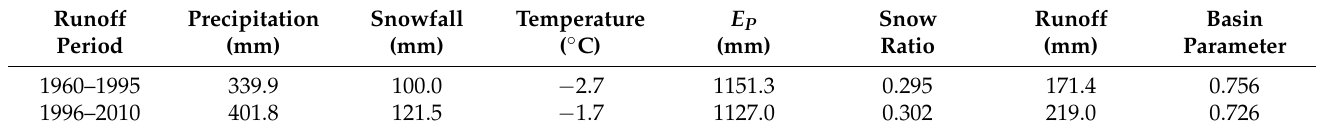
Figure 8. The monthly average air temperature, T max in Equation (1), and empirical temperature from 1960 to 2010 ( a ), and the monthly average snowfall calculated by empirical temperature and Equation (1) ( b ). Table 4. The value of annual precipitation, snowfall, average air temperature, snow ratio, E P , runoff, and basin parameters during the base period (1960–1995) and change period (1996–2010).